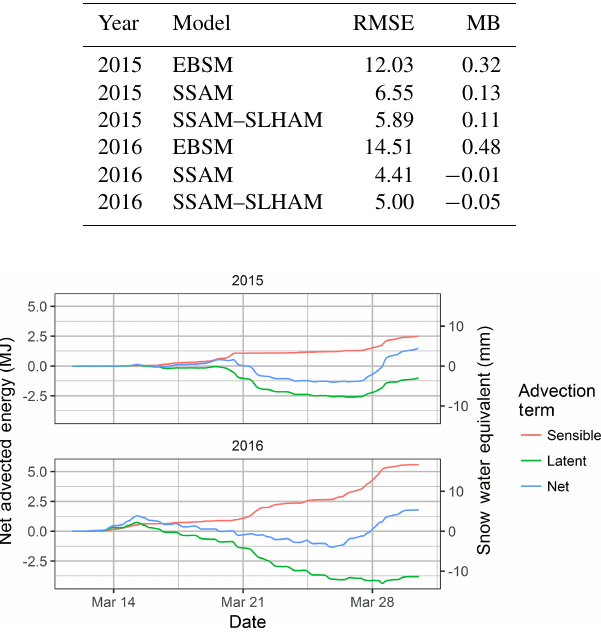
Figure 12. Cumulative sensible (red), latent (green) and net (blue) advection terms in terms of energy (MJ: left) and equivalent melted snow water equivalent (mm SWE: right